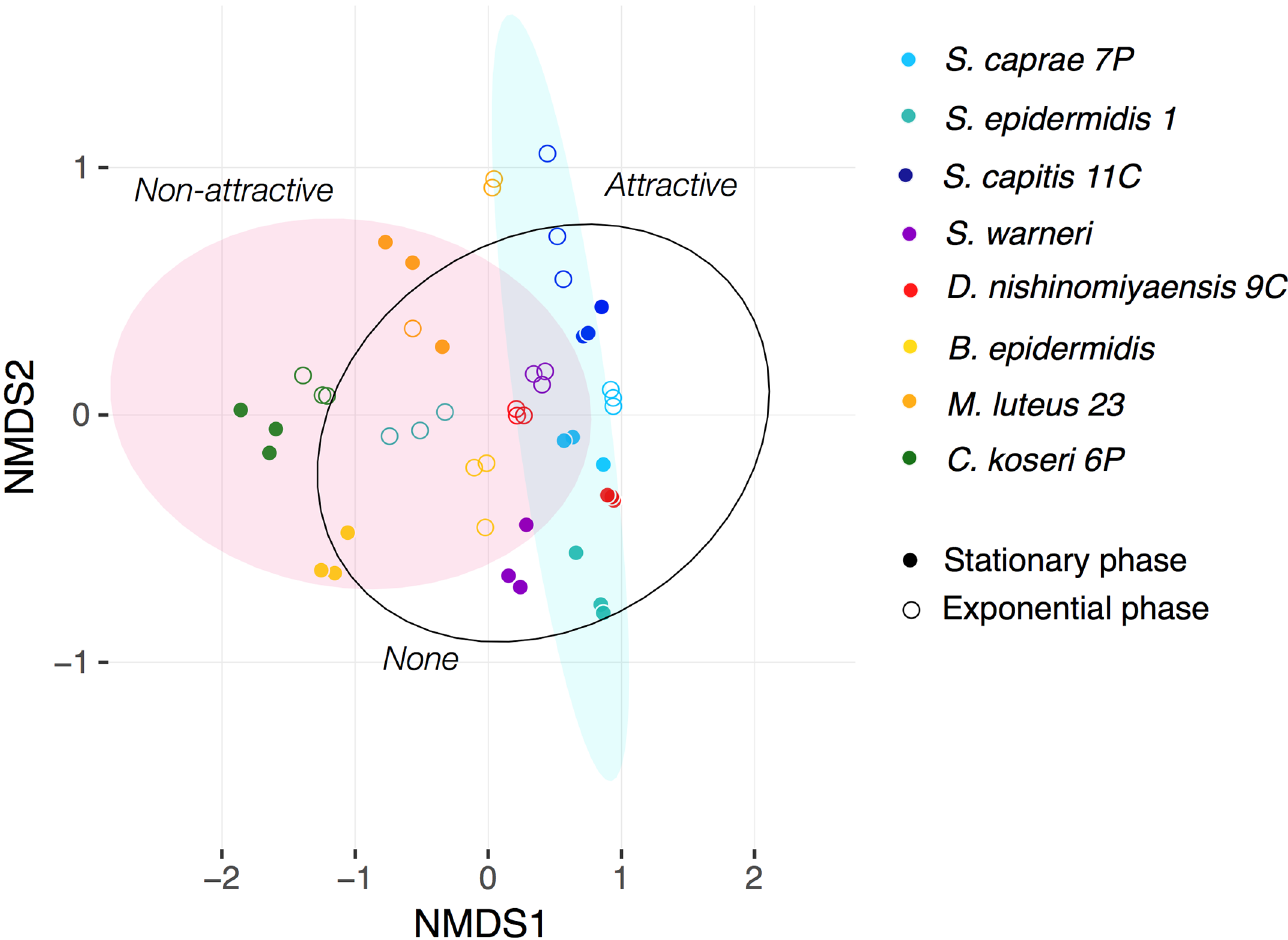
Fig 4. NMDS of VOC profiles from bacteria. Ellipses, according to the response of R . prolixus in behavioral experiments (Attractive/none/non-attractive), describe a confidence interval of 95% using t distribution.